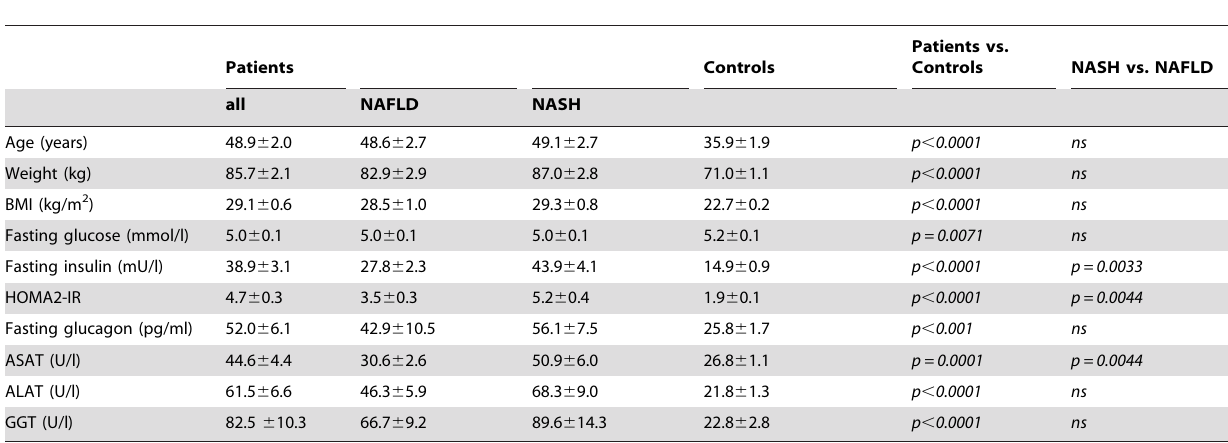
Table 1. Baseline characteristics of Non-alcoholic fatty liver disease (NAFLD) and Non-alcoholic steatohepatitis (NASH) patients and controls.